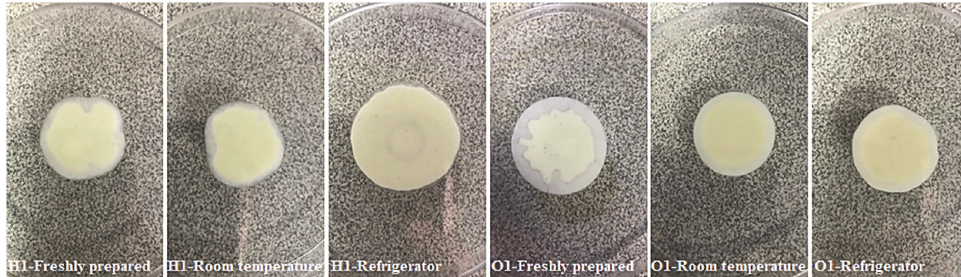
Figure 5. Sample spreadability images of hydrogels and organogels. Hydrogels are coded with letter H and organogels with the letter O.